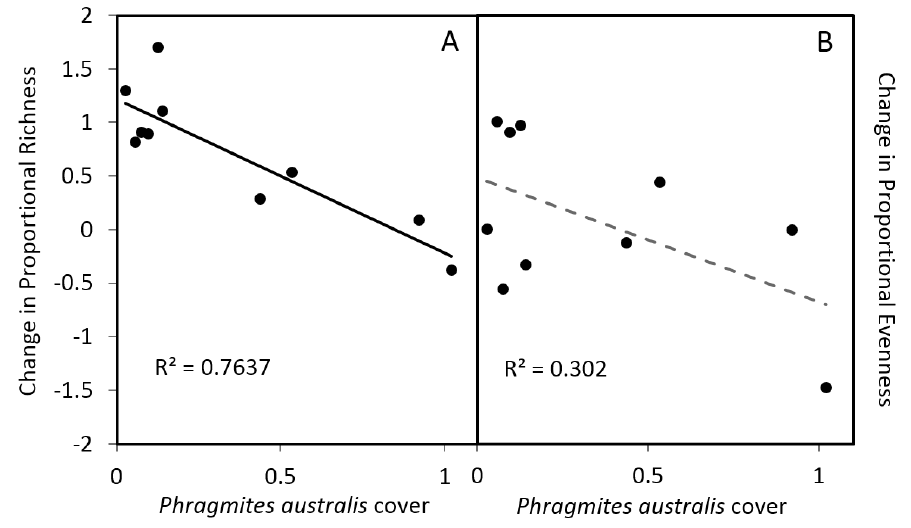
Figure 3. Relationship between Phragmites australis cover (as proportion of area sampled) and the pro- portional change in richness ( A ) and evenness ( B ) in young ponds. The solid line indicates a significant (p <0.05) relationship and dashed line indicates p